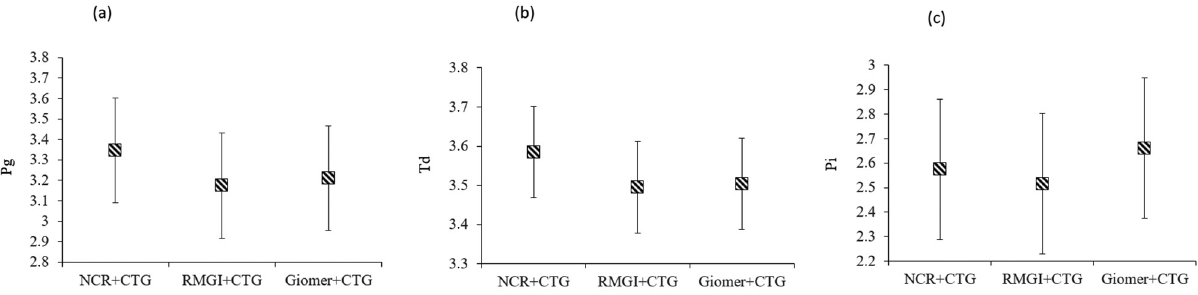
Figure 1- Comparisons of the counts of DNA copies of Pg, Td and Pi (copies/µl) in the treatment groups regardless of time, (a), Porphyromonas gingivalis , (b), Treponema denticola , (c), and Prevotella intermedia , respectively. p<0.05 considered statistically significant, repeated-measures analysis of variance